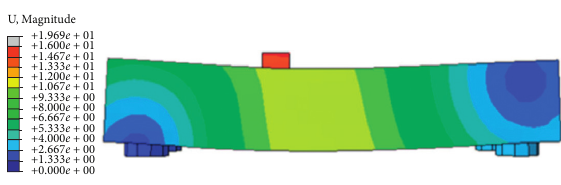
Figure 21: Displacement nephogram of MT-1.